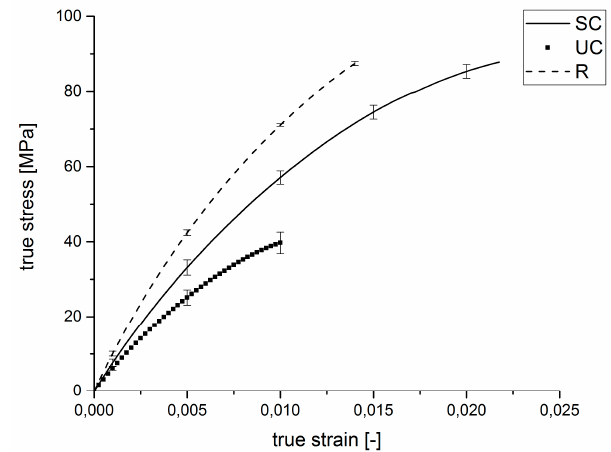
Figure 10. Average stress-strain diagram for the tensile tests of samples with (SC) and without (UC) glass fiber sizing and reference samples (R). glass fiber sizing and reference samples